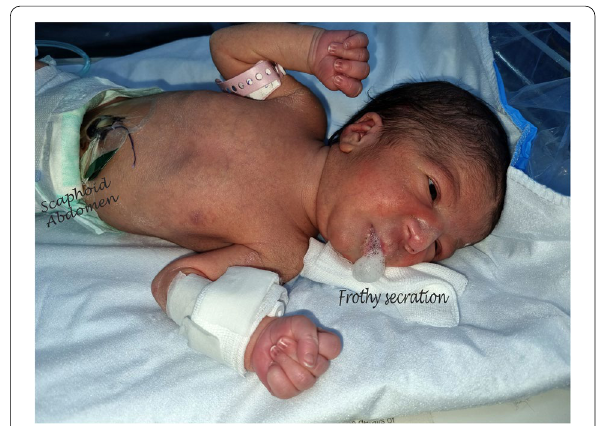
Fig. 1 Frothy oral secretions and scaphoid abdomen